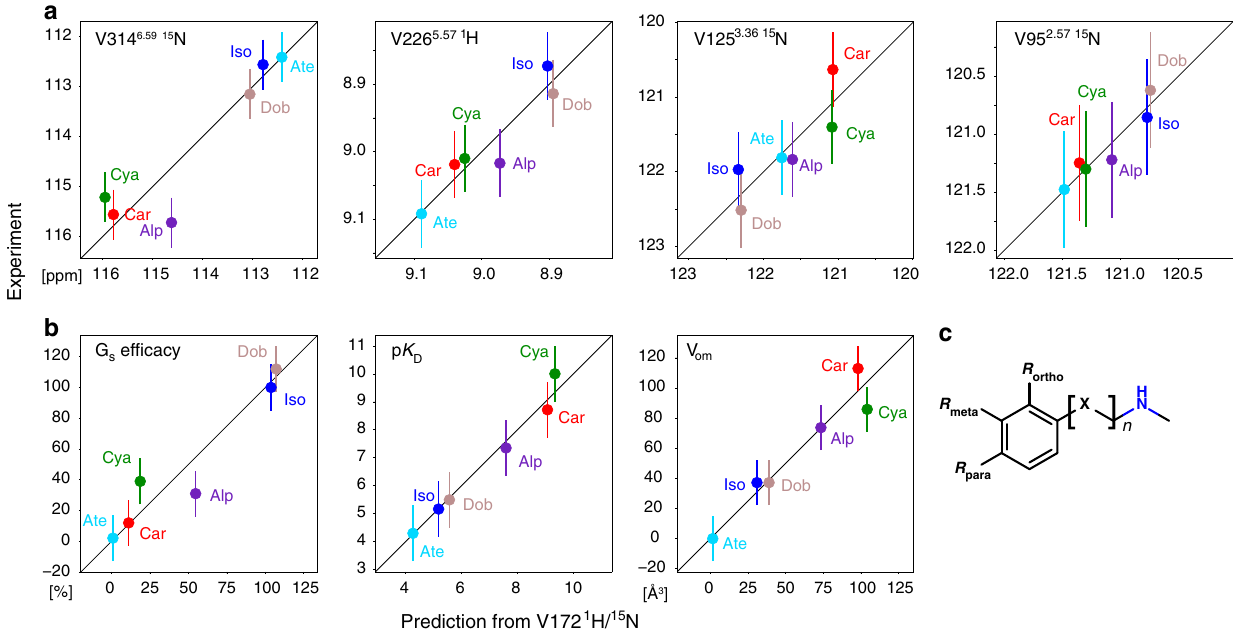
Fig. 5 Prediction of receptor observables from V172 4.56 - 1 H/ 15 N chemical shifts using PCA. Predictions were based on the fi rst two principal components. a Predicted vs. observed chemical shifts V314 6.59 - 15 N, V226 5.57 - 1 H, V125 3.36 - 15 N, V95 2.57 - 15 N. b Predicted vs. observed G s ef fi cacy, ligand af fi nity p K D and volume of ortho, meta ligand head group substitutions ( V om ). Error bars in a and b are estimates for the agreement between measured and predicted chemical shifts ( 1 H: 0.05 ppm, 15 N: 0.5 ppm) and ligand parameters (G s ef fi cacy: 15%, p K D : 1.0, V om : 15 Å 3 ), which were based on the overall quality of the PCA fi t. c Substitution pattern of the aromatic ligand head group. Source data are provided as a Source Data fi